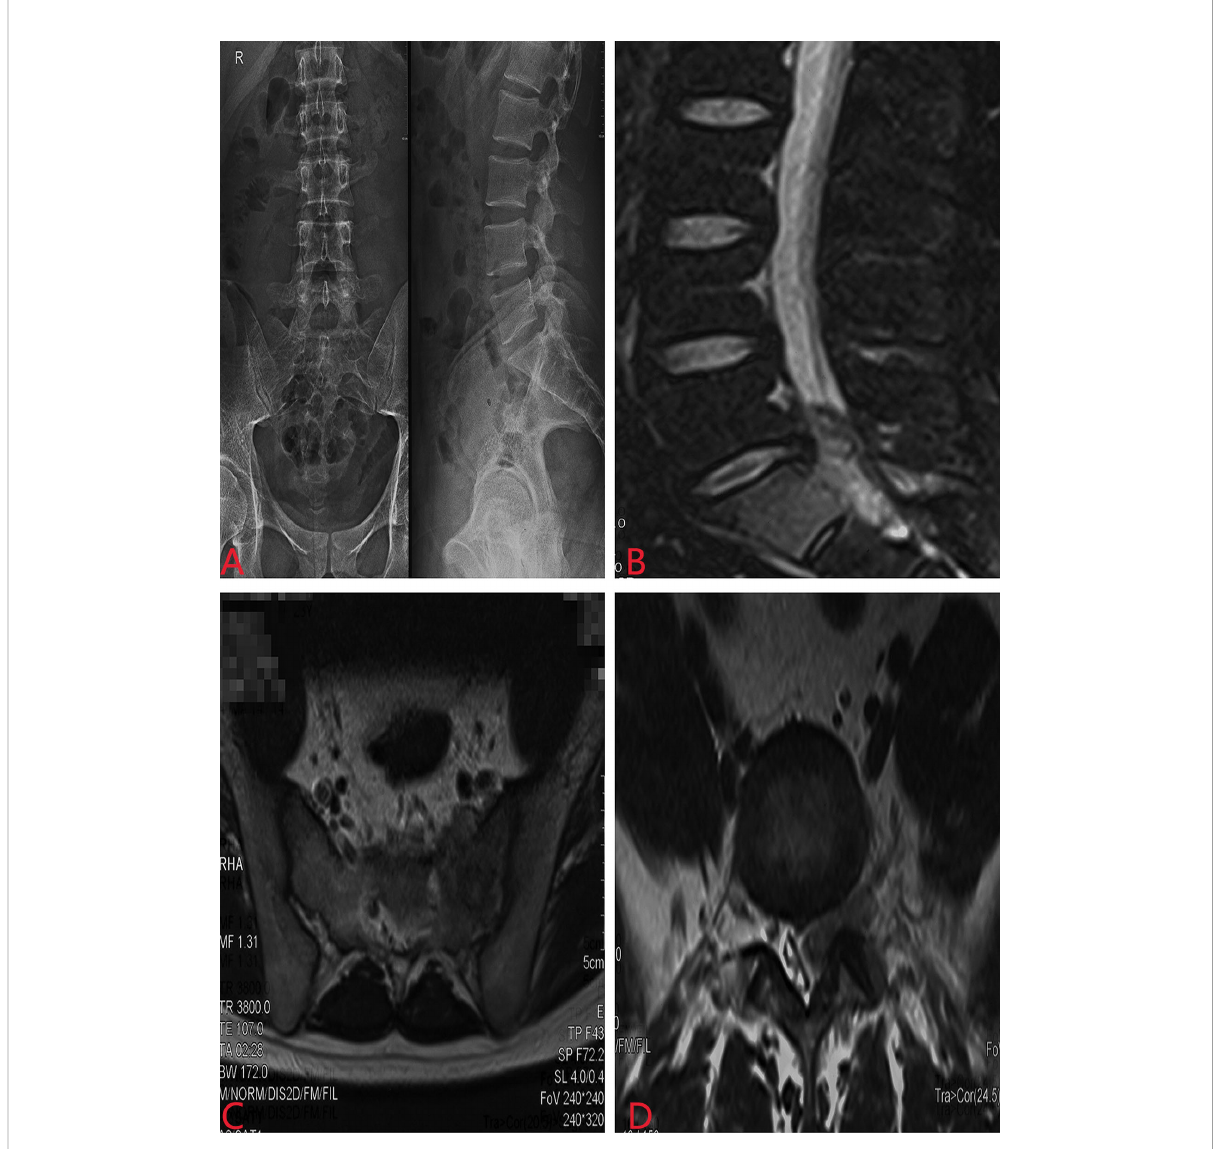
FIGURE 1 Preoperative X-ray and MRI revealed a space-occupying lesion with abnormal signal of the sacrum at the S1 level. (A) X-ray of the lumbosacral spine; (B) sagittal MRI; (C) coronal MRI; (D) lateral